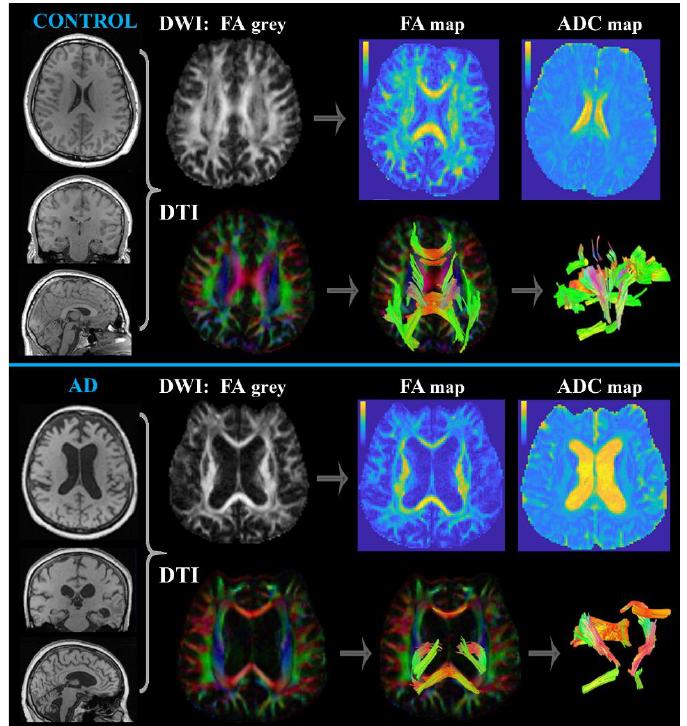
Figure 3. Example of MRI (T 1 -weighted MRI at 3 Tesla MR-scanner), DWI, and DTI (performed on DSI studio software incorporating MATLAB postscripts) neuroimaging of a control subject (50-year-old male) and AD patient (56-year-old female). AD exhibits more restricted diffusion in the tissue, a worse global network density, and lost white matter fiber tracts. Abbreviations: ADC, apparent diffusion coefficient; DTI, diffusion tensor imaging; DWI, diffusion weighted imaging; FA, fractional anisotropy.